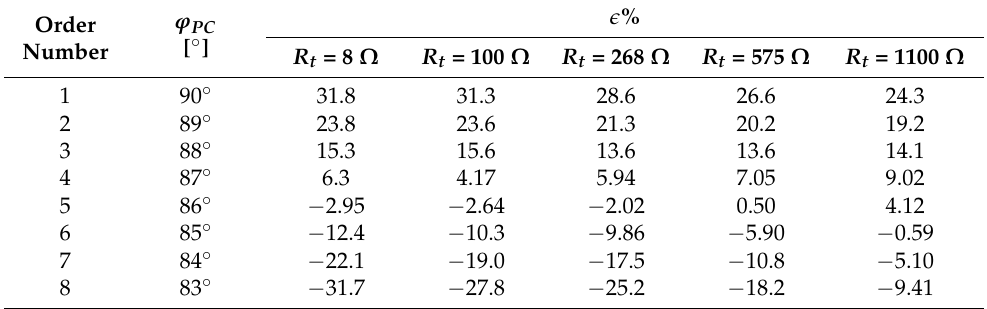
Table 12. The difference between the effective values of the fault current determined experimentally and analytically ( ϕ c = 85.3 ◦ ).